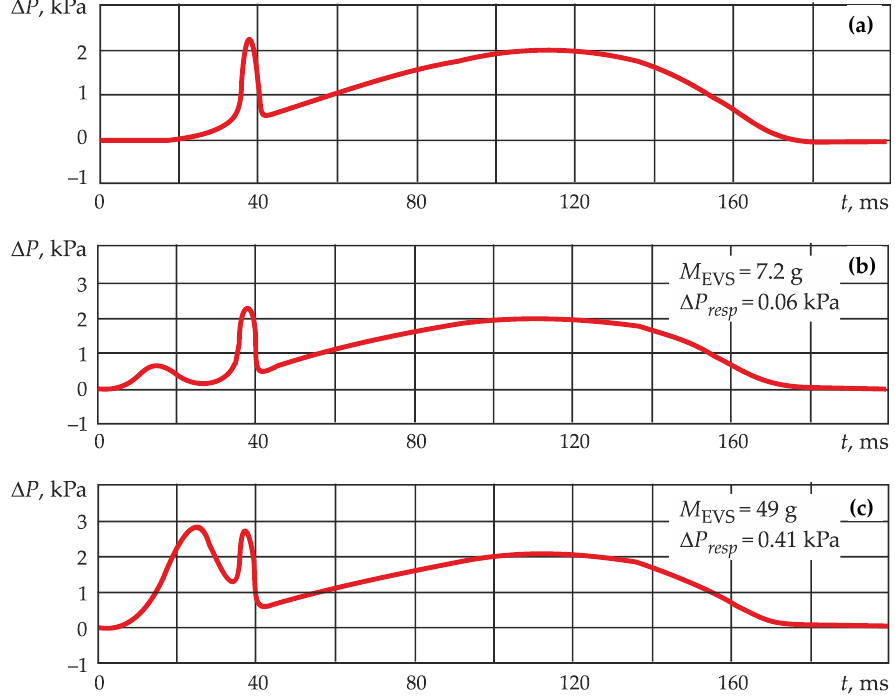
Figure 2. A math waveform of pressure following an explosion of a propane-air mixture in a cubic chamber ( h = 305 mm): ( a ) uncovered openings; ( b , c ) openings covered with EVS-simulating panels.